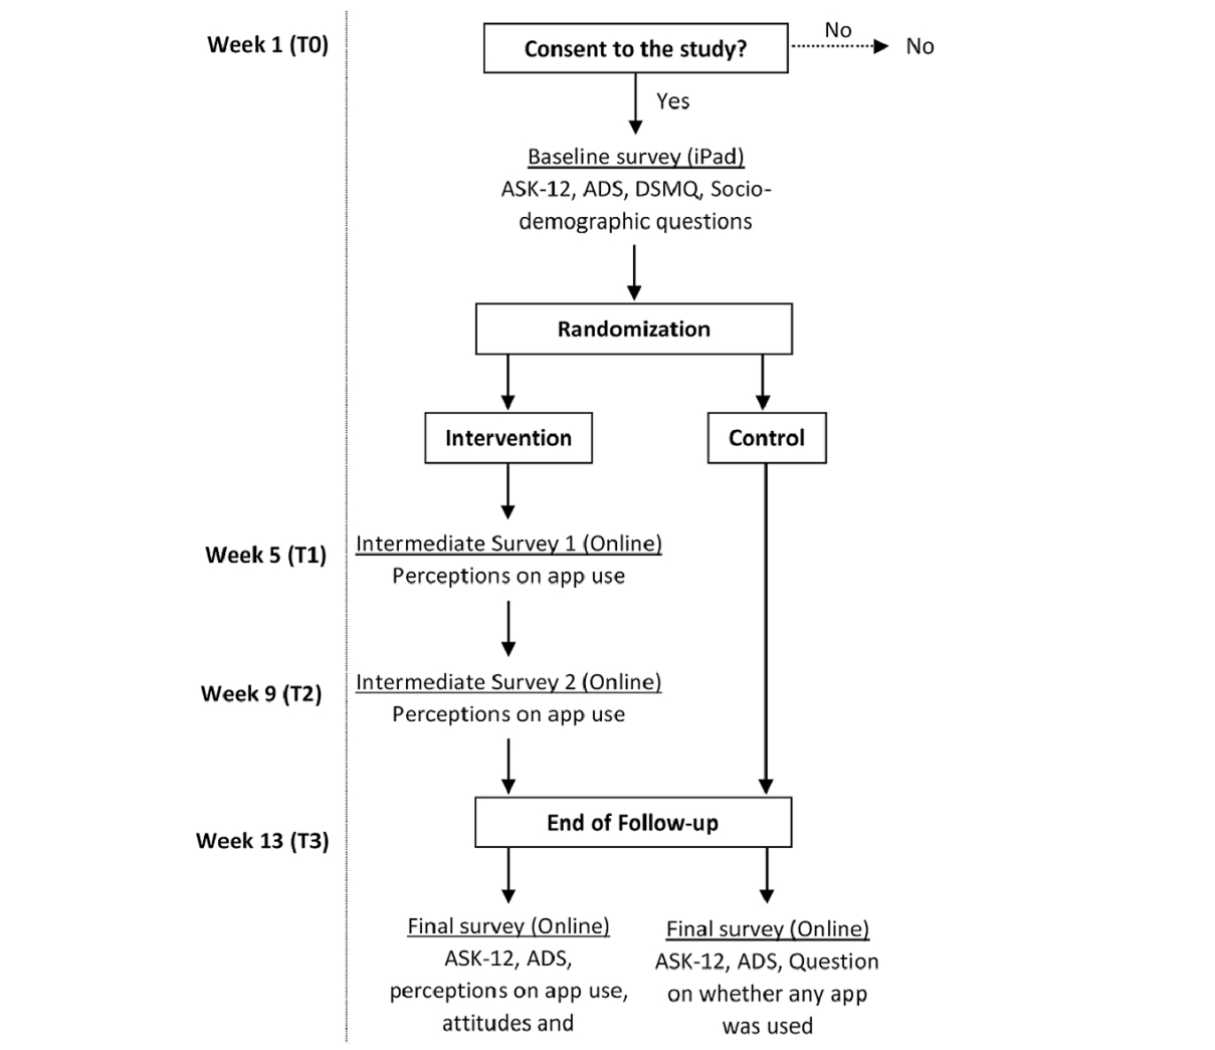
Figure 1. Schedule of outcome measurements. ASK-12: Adherence Starts with Knowledge-12, ADS: Appraisal of Diabetes Scale, DSMQ: Diabetes Self-Management